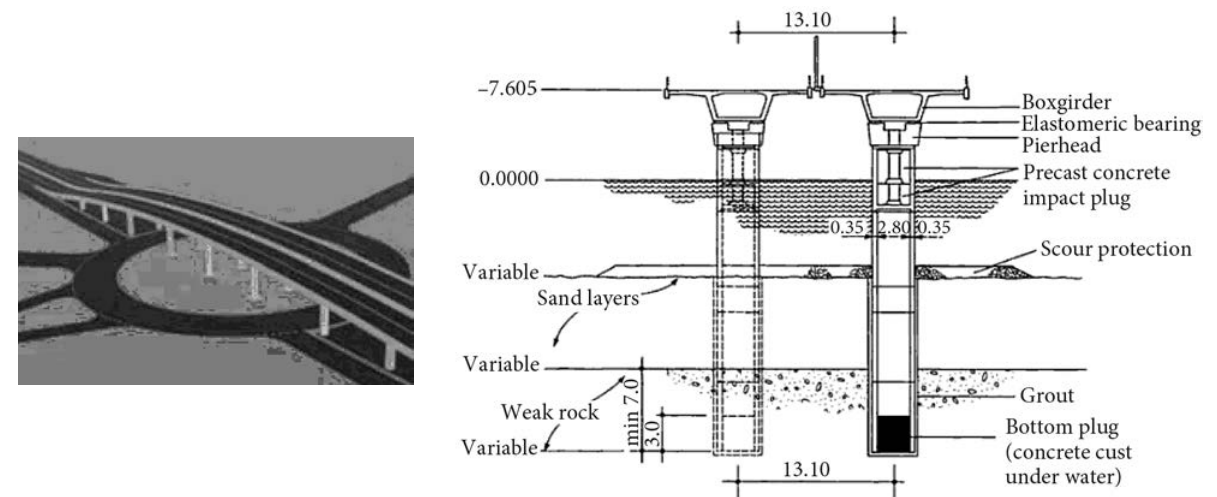
Fig. 1. Stand alone foundation piles-columns for buildings and bridges, dimensions in